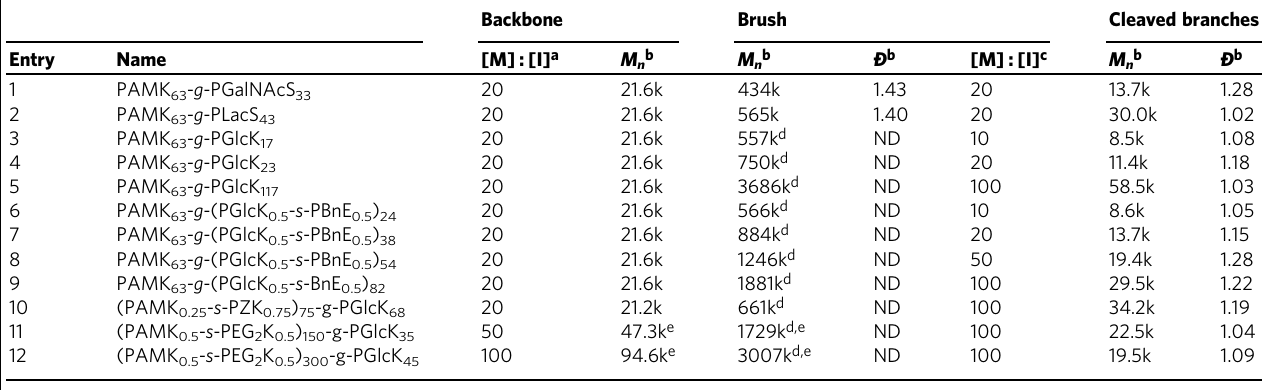
Table 1 Representative polymerization data for tunable glycobrushes. Backbone Brush Cleaved